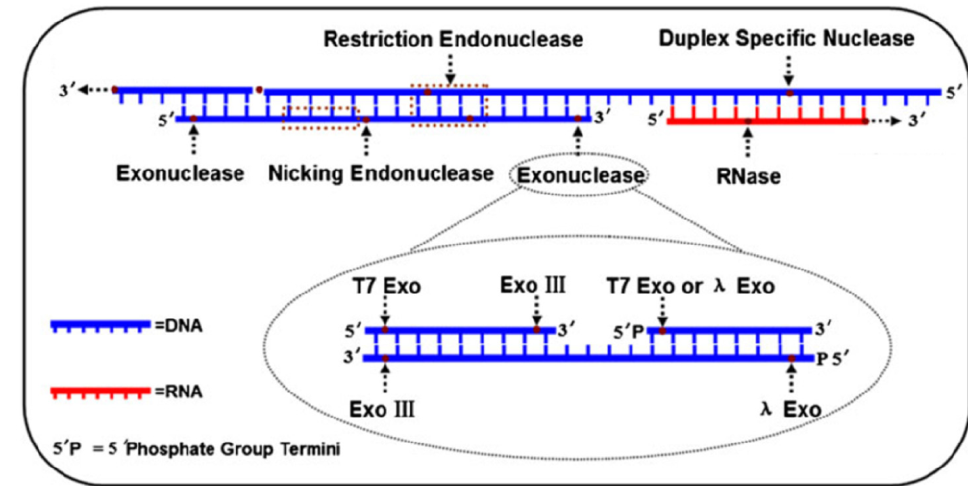
Figure 1. A scheme of different nucleases with different functions. Reprinted with permission from ref. [36]. Copyright 2015 Springer